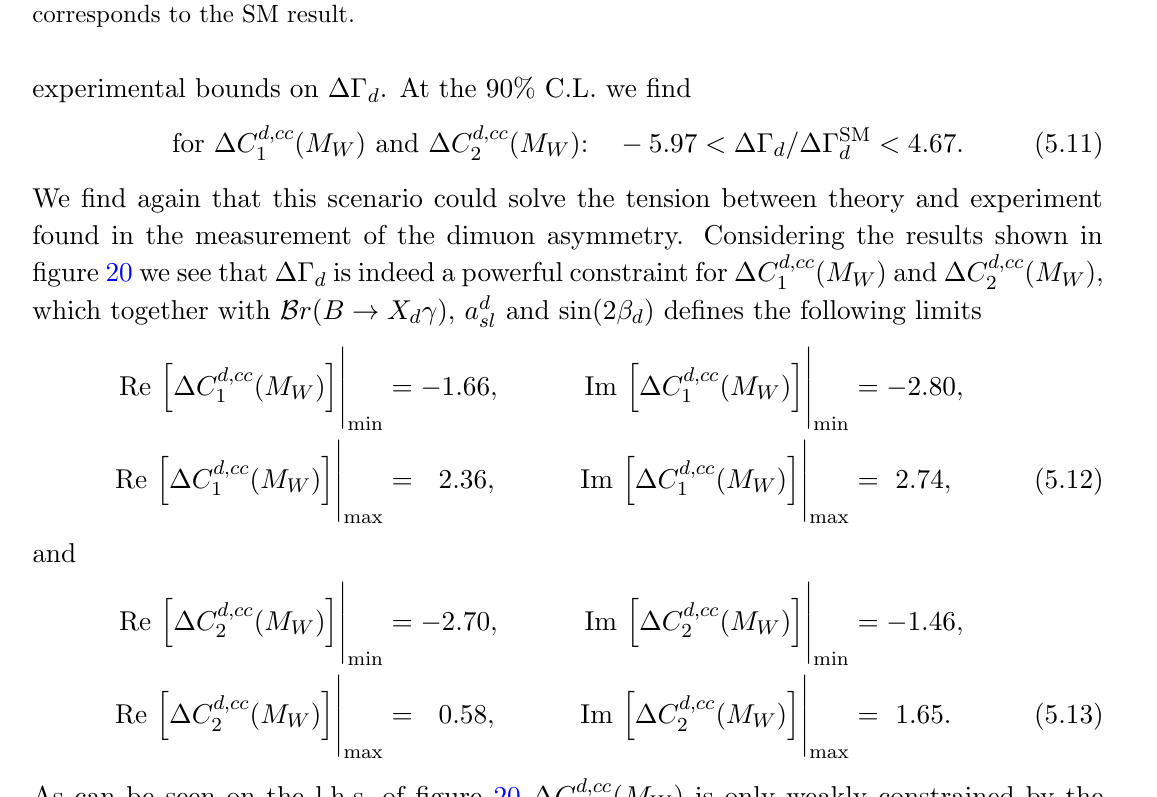
Figure 20 . Global (cid:31) 2 -(cid:12)t including observables constraining the inclusive transition b ! c (cid:22) cd . The 90% C.L. allowed regions correspond to the areas contained within the black contours. The colored curves indicate the possible enhancements on (cid:1)(cid:0) d with respect to the SM value. The black dot corresponds to the SM